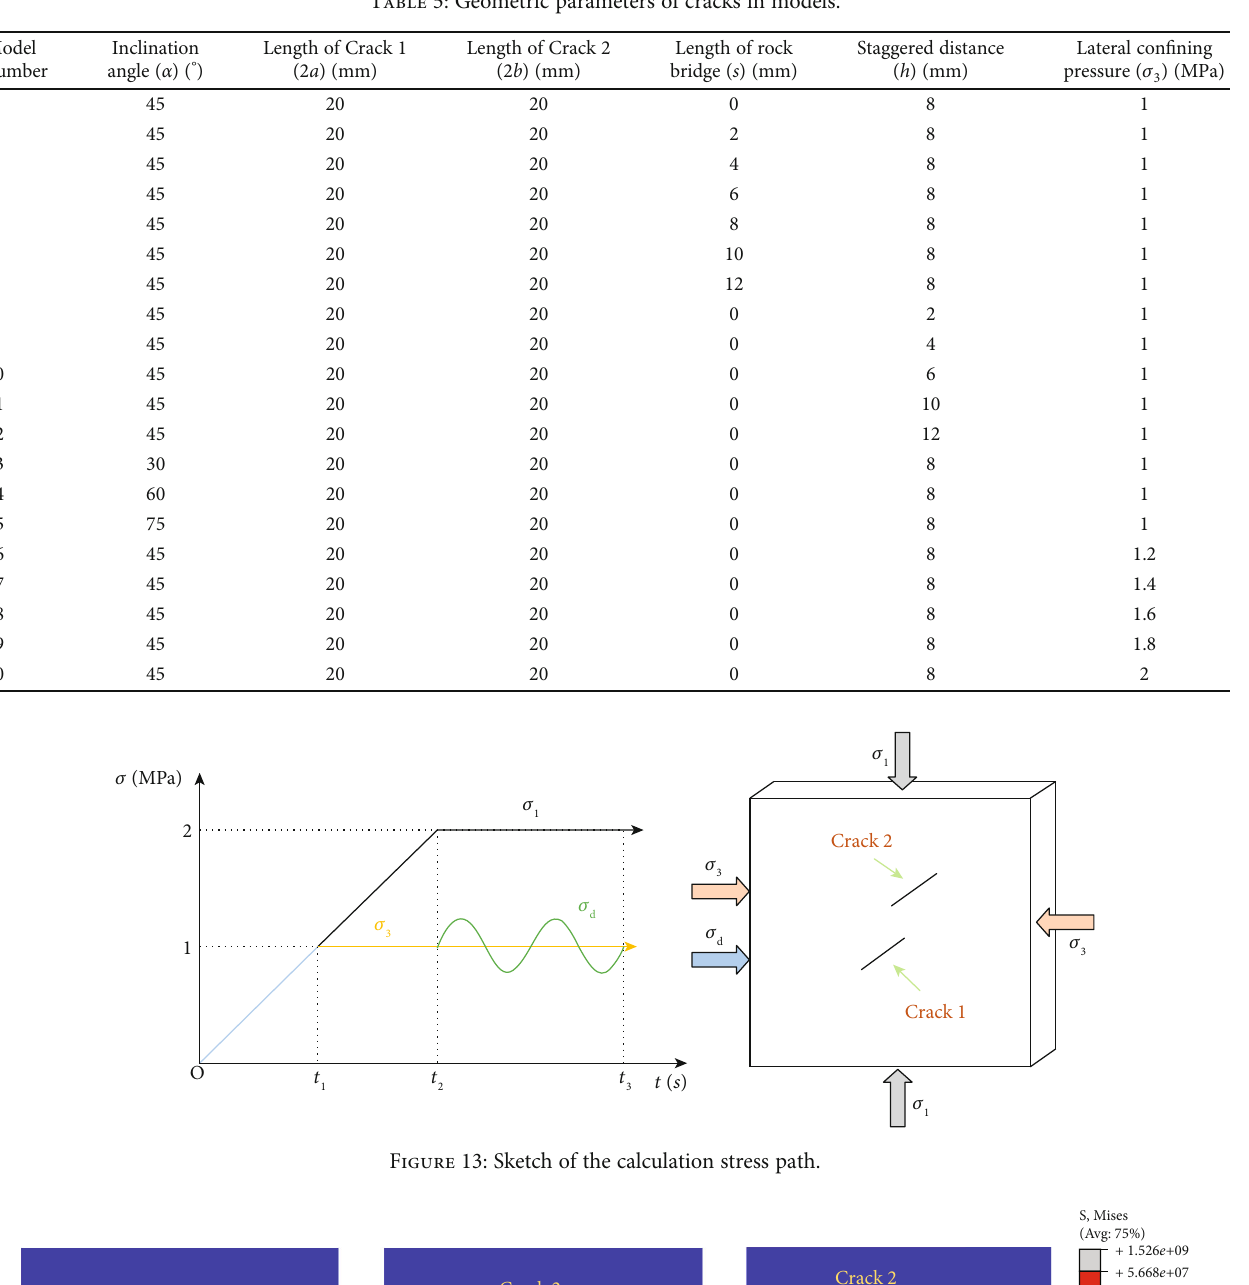
Table 5: Geometric parameters of cracks in models.